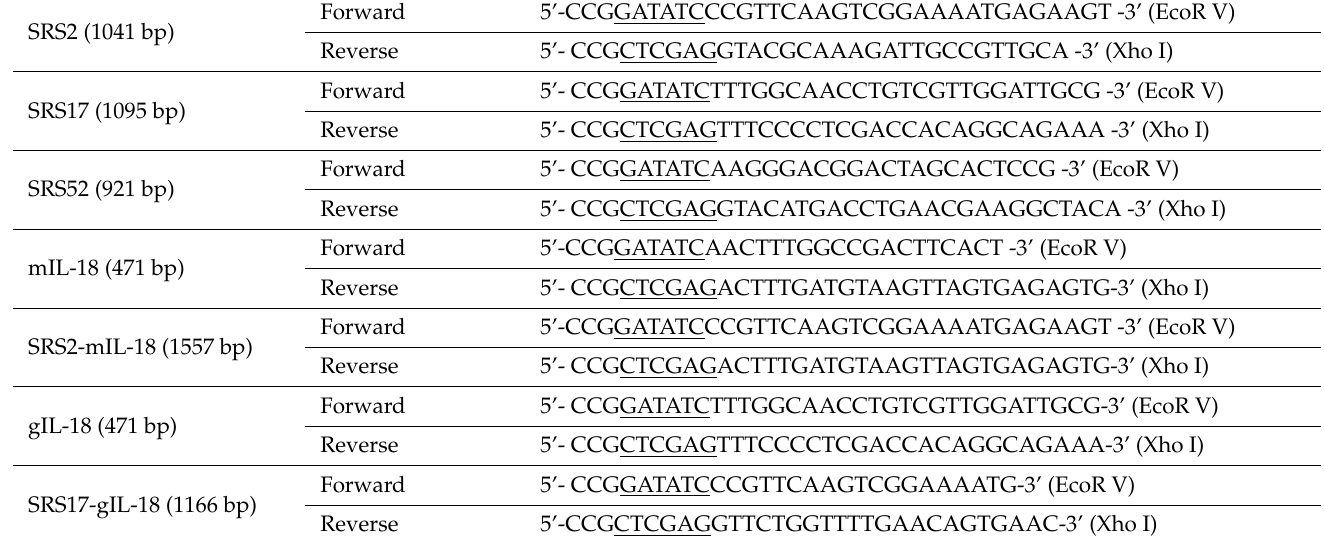
Table 1. Synthetic primers of the NcSRS2 (NCLIV_033250), NcSRS17 (NCLIV_068920), NcSRS52 (NCLIV_069780) or mIL-18 (NM_008360) (mature peptide) gene. It represents the digestion